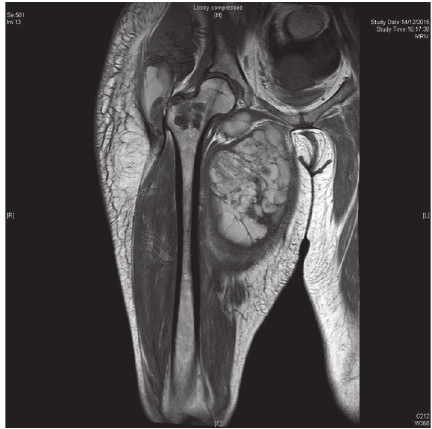
Figure 3: Magnetic resonance imaging (T2-weighted) of the right hip.